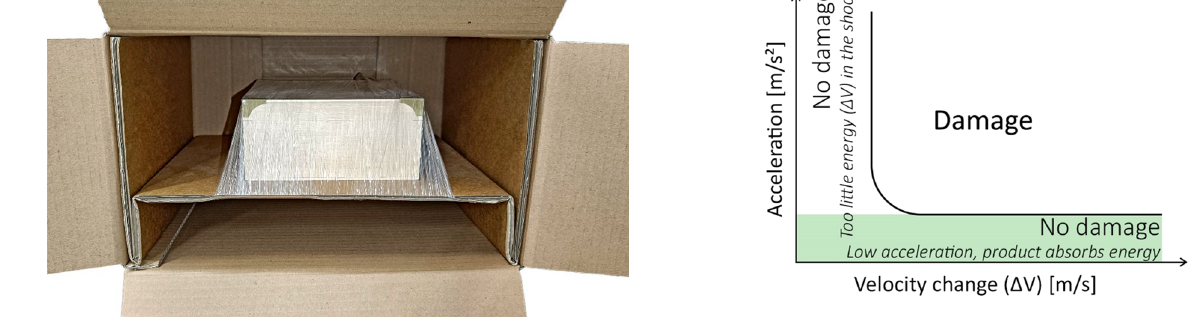
Fig. 1 3S-packed wooden gift box